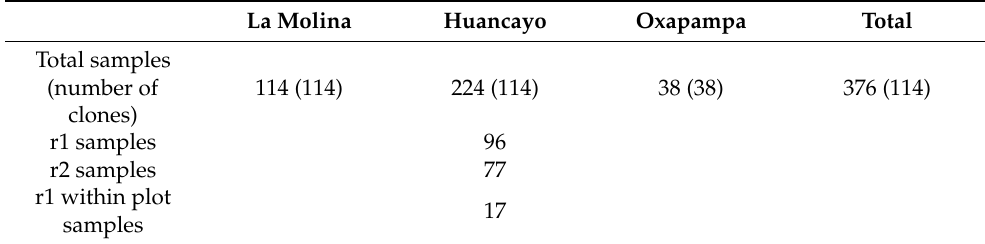
Table 2. Counts of genotypes and samples used for the QC assessment; r1 and r2 denote the first and the second replication of the Huancayo intermediate trial,